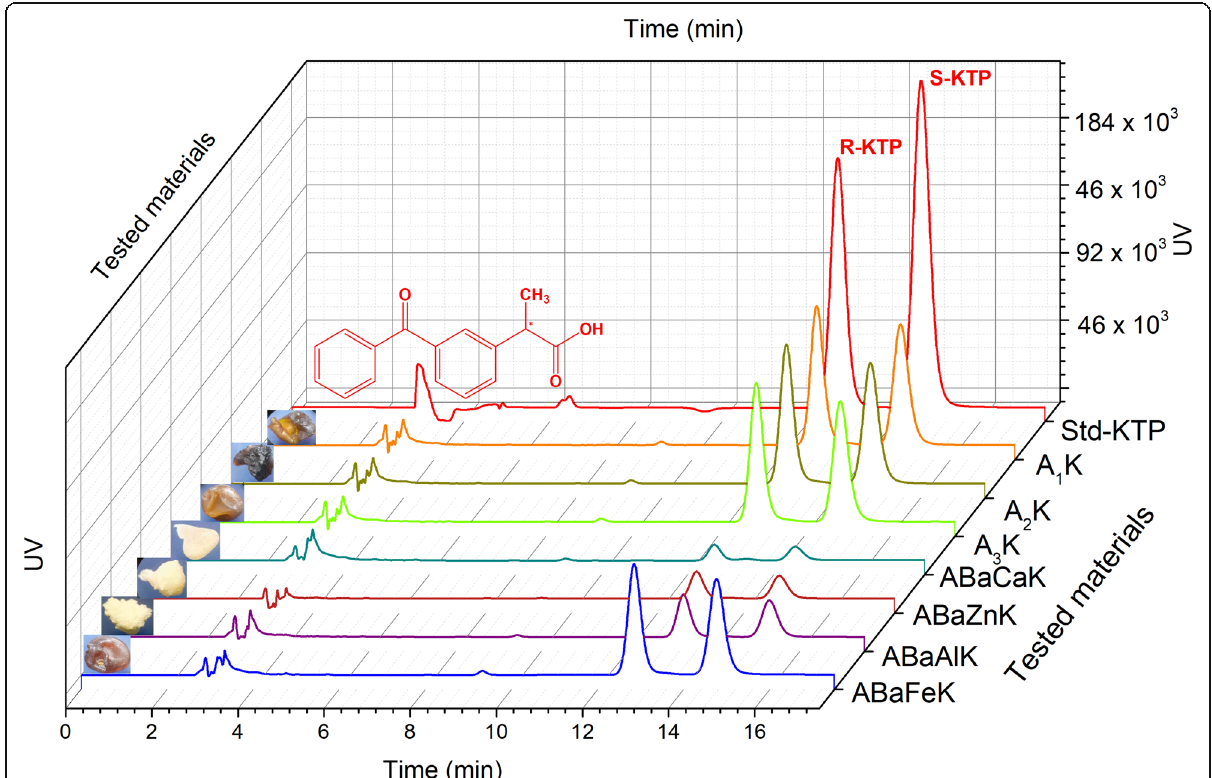
Fig. 7 HPLC chromatograms for single metal beads and reference ketoprofen